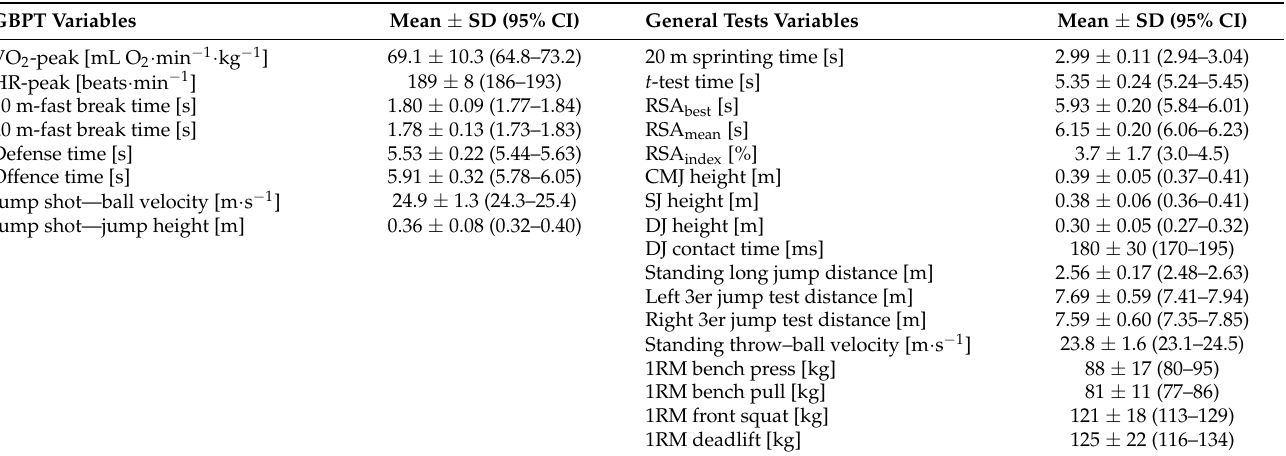
Table 1. Descriptive data, mean, standard deviations ( ± SD) and 95% confidence intervals (CI) for all variables in the game-based performance test (GBPT) and general